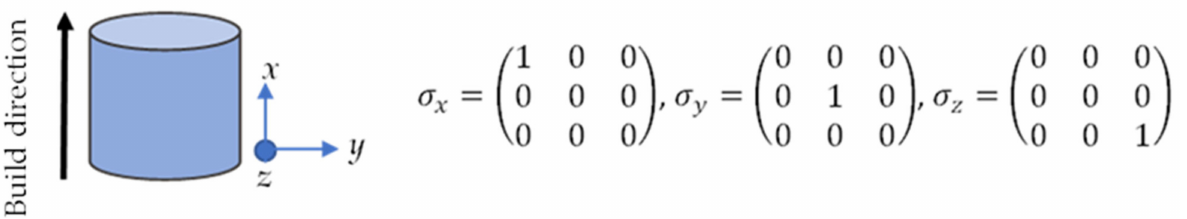
Figure 2. Illustration of the specimen loading axis and respective second rank stress tensors along each of the axes.